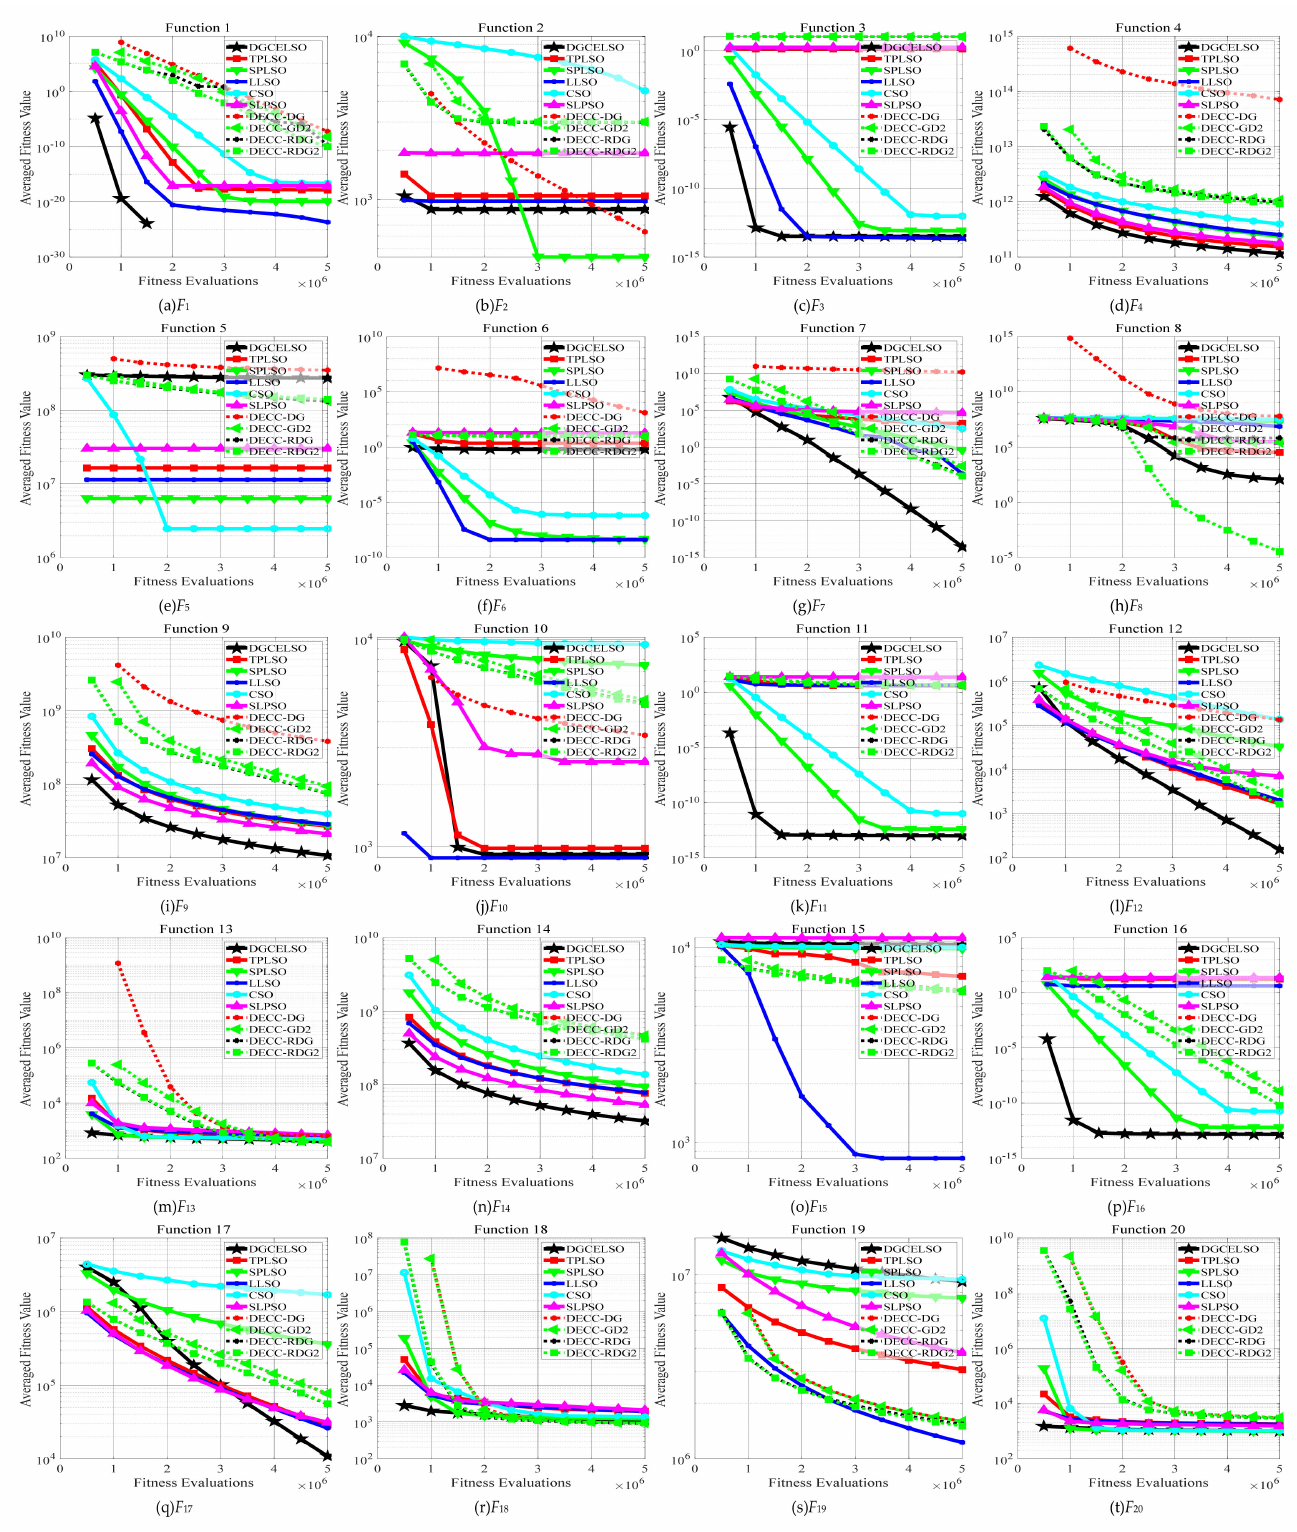
Figure 3. Convergence behavior comparison between DGCELSO and the compared algorithms on each 1000-D CEC’2010 benchmark